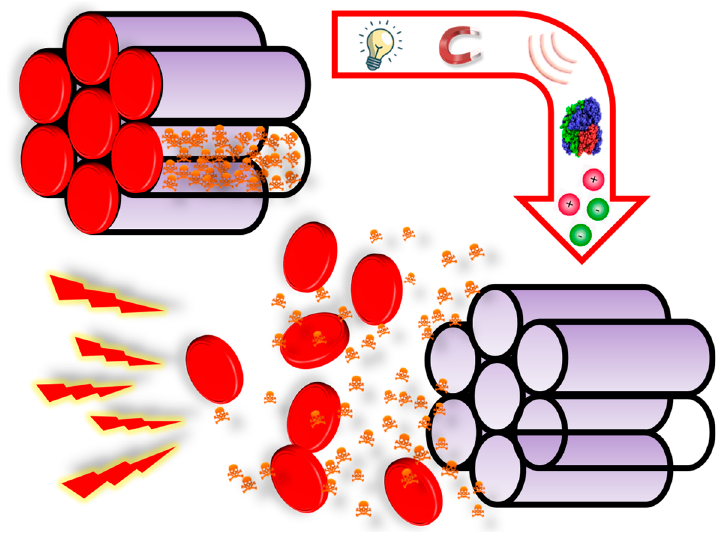
Figure 7. Schematic representation of how stimuli-responsive mesoporous materials work. The gatekeepers close the pore entrances and avoid premature release until some specific stimulus is applied. The stimuli can be applied from inside (e.g., pH, redox species, enzymes) or outside the patient (e.g., light, US, magnetic fields).